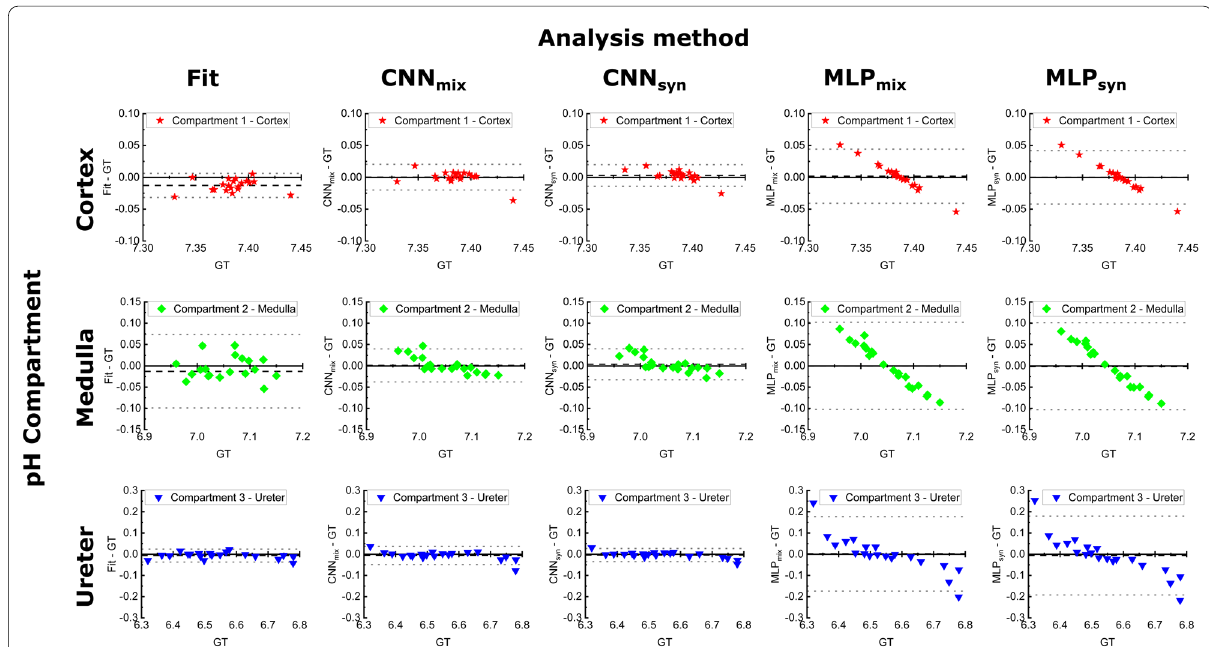
Fig. 5 Modified Bland–Altman plots showing the difference between predicted and ground truth pH values from synthetic kidney test spectra against the ground truth pH for each compartment. Black dashed lines indicate the mean difference and grey dotted lines indicate the 95% confidence interval for this